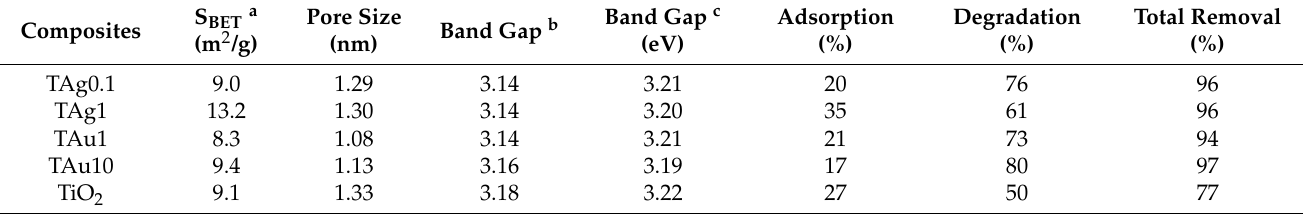
Figure 13. Total removal of MB (%): ( a ) ( ■ ) TAg0.1 and ( ■ ) TAg1; ( b ) ( ● ) TAu1 and ( ● ) TAu10. Both graphs use ( ▲ ) TiO 2 as a reference. Table 1. BET surface area, band gap, adsorption, degradation, and total removal percentages of MB in TiO 2